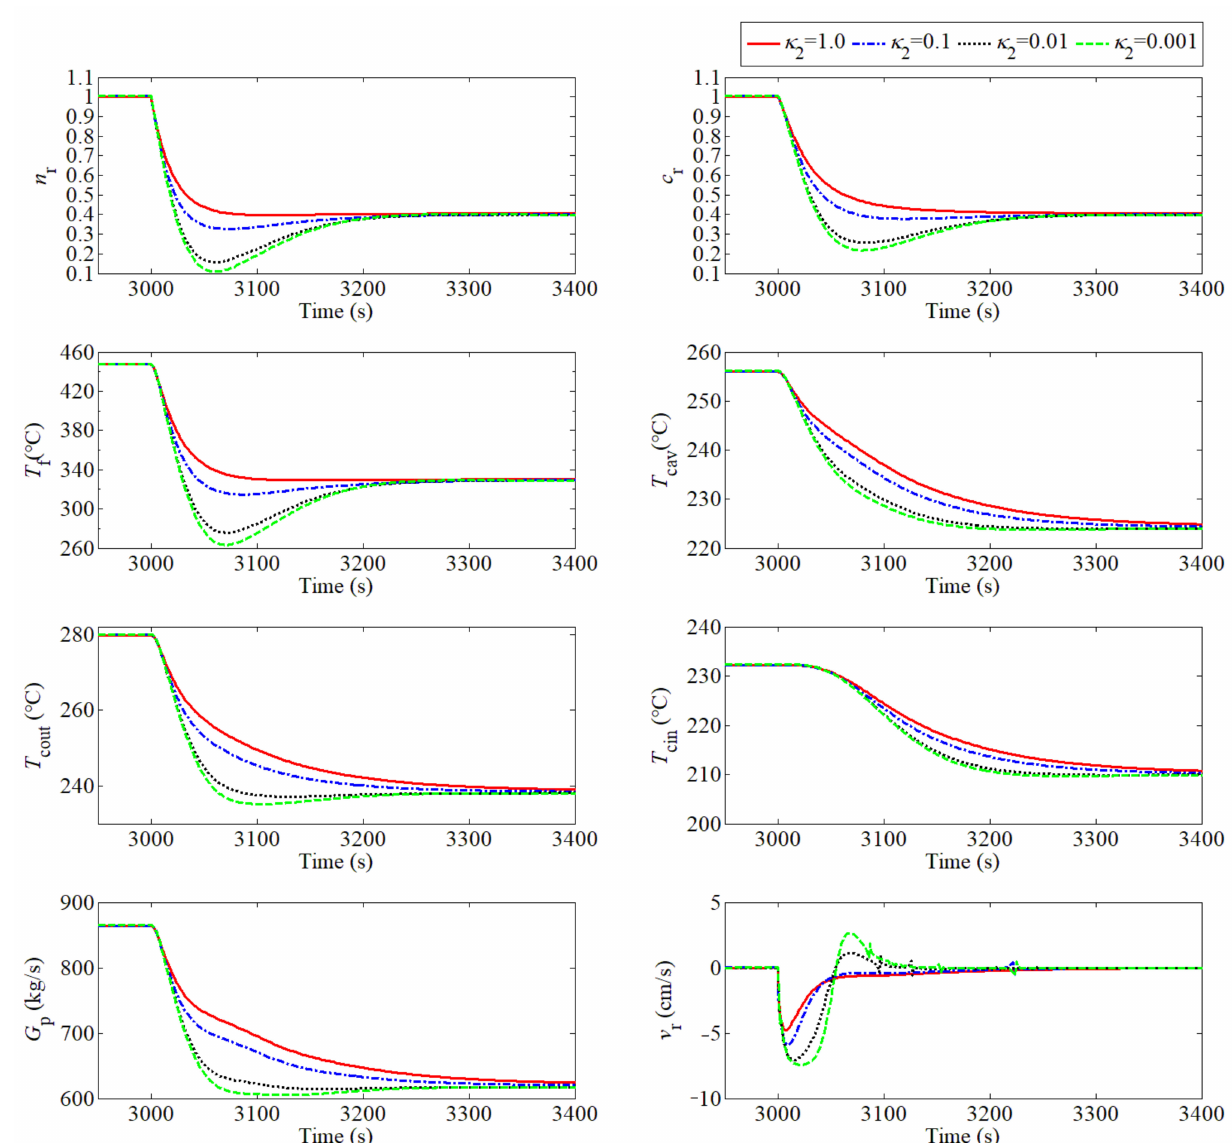
Figure 3. Responses in power stepping with κ 1 = 1 and different κ 2